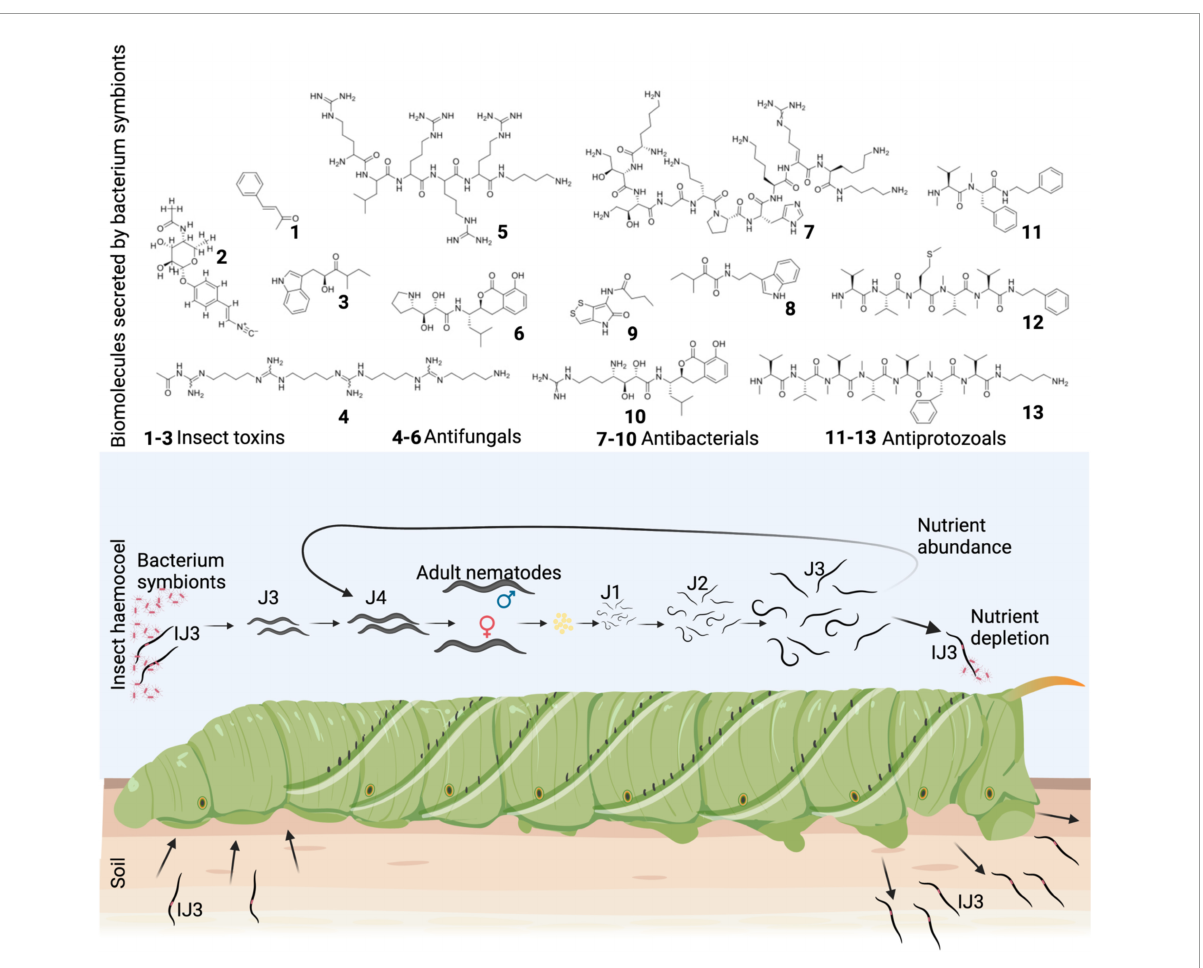
FIGURE1 Xenorhabdus-Steinernema lifecycle and selected biomolecules that contribute toward nematode fecundity. Free-living infective third-stage juvenile (IJ3) nematodes seek out insects and gain entry through natural openings such as spiracles, and once within the hemocoel, nematodes exit their non-feeding state and release Xenorhabdus gut symbionts. The bacteria secrete a range of biomolecules (1–13) that increase the fecundity of the nematodes. Nematodes go through complete lifecycles thus increasing their numbers and upon depletion of nutrients each J3 re-associates with a few Xenorhabdus bacteria and exit the insect cadaver as an IJ3. J1, J2, J3, and J4 = first, second, third, and fourth larval stage juvenile nematodes, respectively. Benzylacetone (1), rhabduscin (2), xenocyloin (3), cabanillasin (4), biocornutin (5), xenocoumacin 2 (6), odilorhabdin (7), nematophin (8), xenorhabdin (9), xenocoumacin 1 (10), xenortide (11), rhabdopeptide (12), and rhabdopeptide/xenortide-like peptides (13) were created in